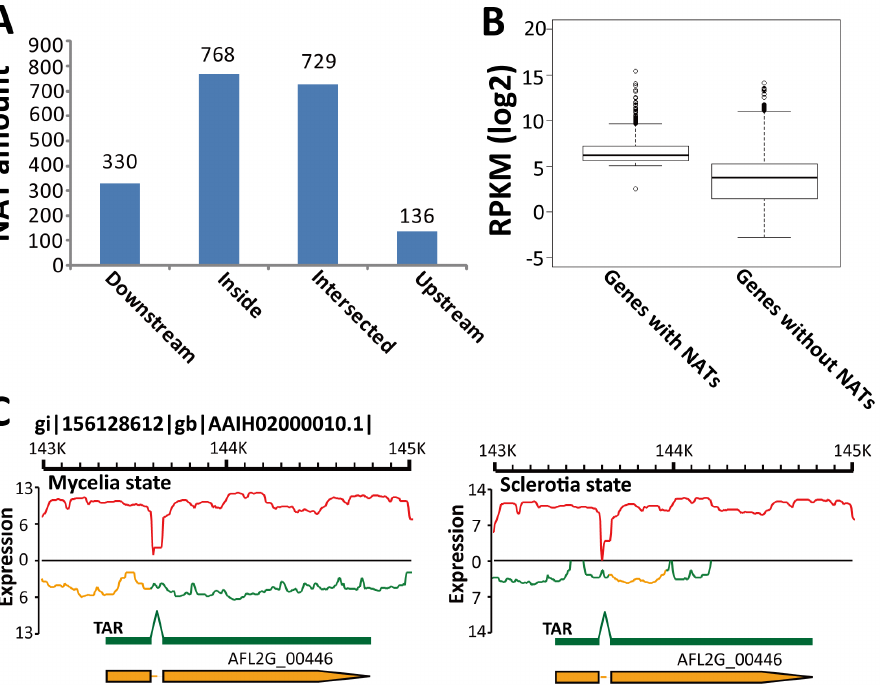
Figure 5. NAT analysis in A.flavus CA43. (A) The relationship between the location of NAT and its corresponding genes. Downstream, Upstream and Inside, NATs located in the downstream, upstream or inside of their corresponding genes, respectively. Intersected, NAT located across one gene and its 5 9 - or 3 9 - flanking region. (B) Box and whisker plots of log 2 -transformed RPKM for A. flavus annotated genes with or without NATs. (C) Occurrence of NAT in the SdeA gene (AFL2G_00446). Orange curves, the NAT in the SdeA gene.